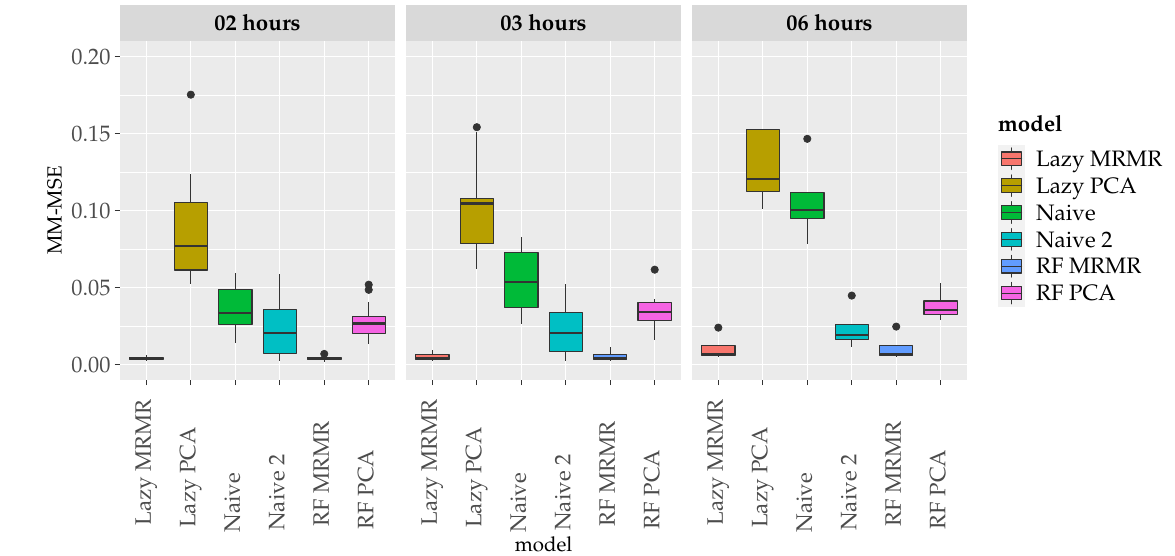
Figure 7. Visualization of MM-MSE at the changing of Forecasting Horizon.